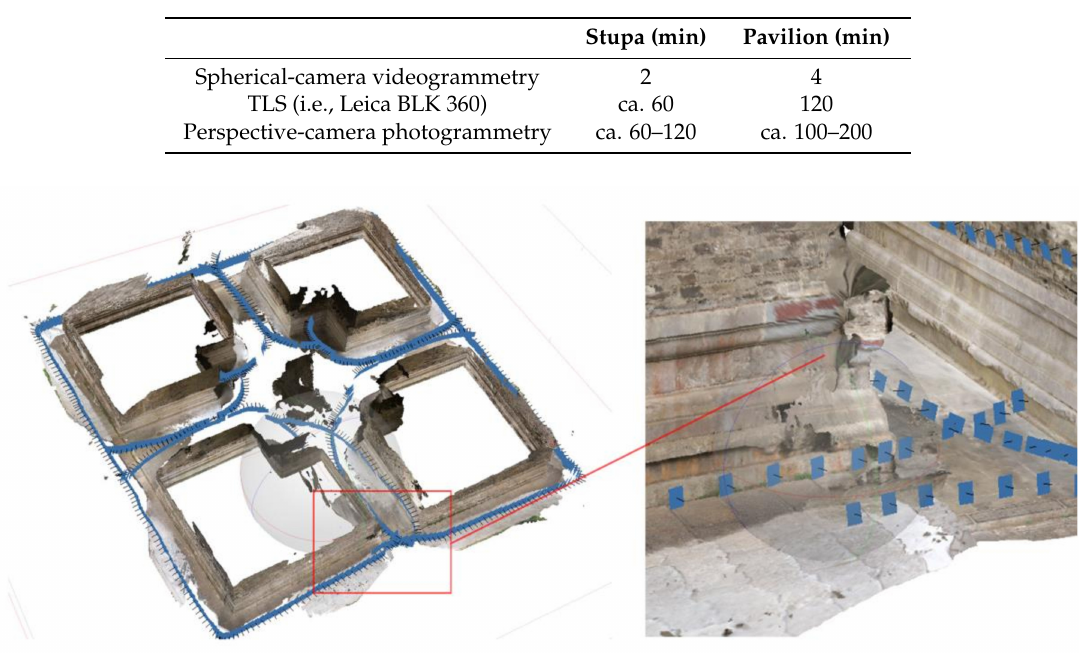
Table 6. Comparison of on-site time of the tested method with other optical measurement methods. TLS: terrestrial laser scanning.